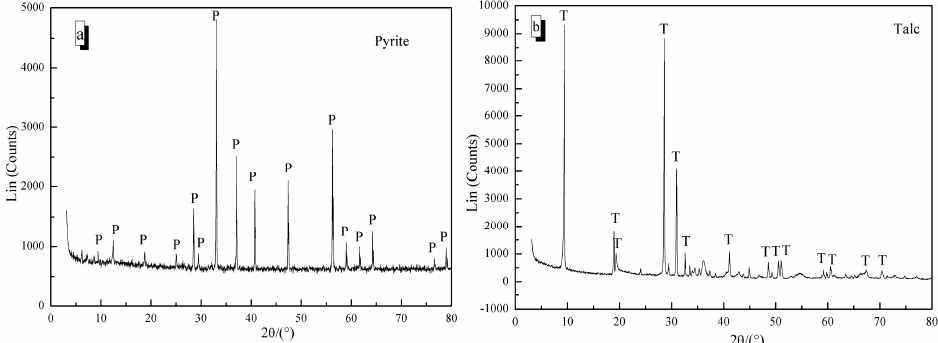
Figure 1. XRD patterns of the purified samples: ( a ) pyrite; ( b ) talc (P = pyrite, T = talc).